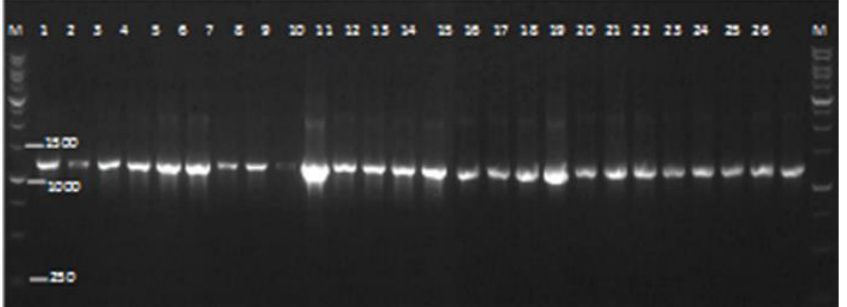
Figure 1. Electrophoretic separation of the PCR products of L. lactis . M — marker – Nova 1 kbp ladder (Novazym), 1 – 26 numbers of isolates.